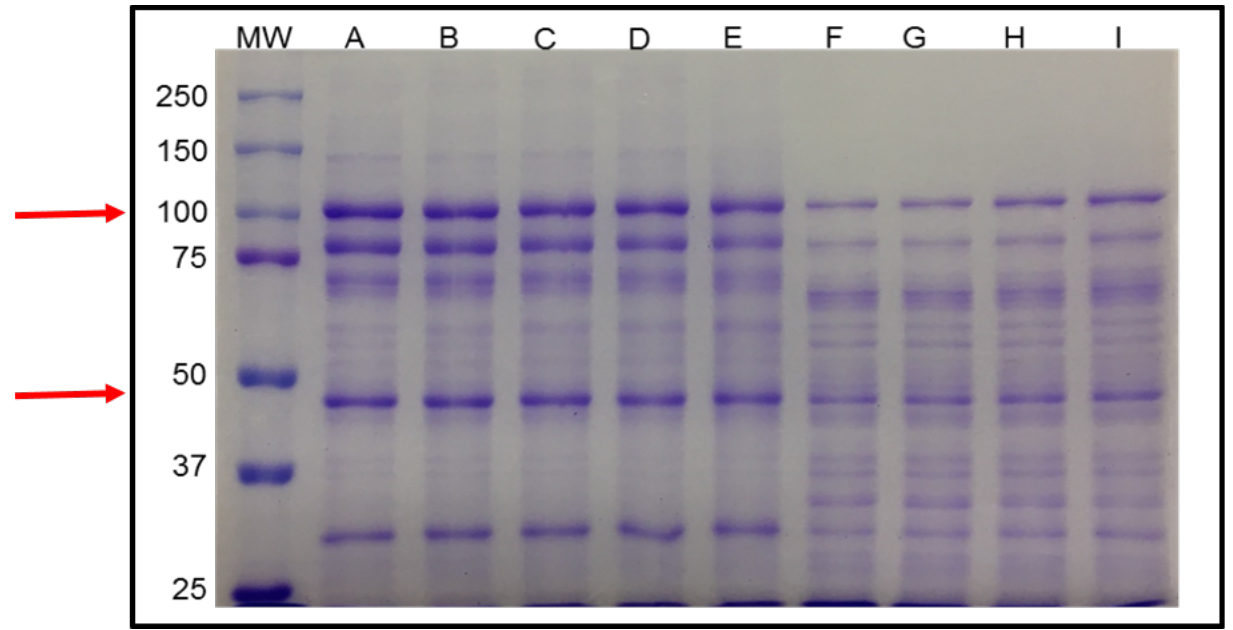
Figure 2. SDS-PAGE under reducing conditions (7.5% polyacrylamide gel, Mini Protean II System, Bio-Rad) of (A) native TeNT and TeNT irradiated with (B) 1 kGy, (C) 2 kGy, (D) 3 kGy, (E) 4 kGy; (F) 5 kGy; (G) 6 kGy, (H) 7 kGy and (I) 8 kGy. (MW) Molecular mass markers (Precision Plus Protein TM Standards Bio Rad: mixture of 10 recombinant proteins, 10-250 kDa, 8 blue-stained bands and 2 pink reference bands – 25 and 75 kDa). Arrows point to tetanus toxin 100 kDa (heavy chain) and 50 kDa (light